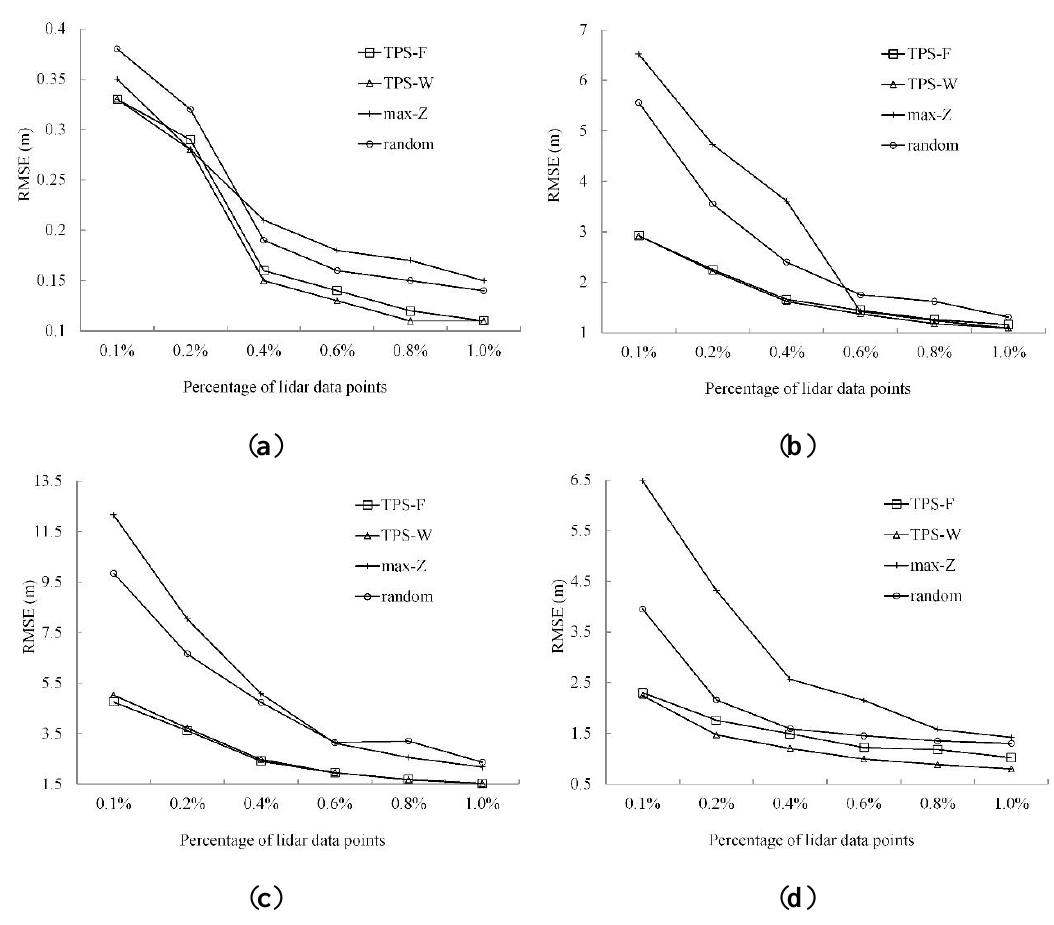
Figure 12. Comparison of percentage of LiDAR data points ( i.e. , ratio of the number of selected critical points to the whole number of LiDAR points) versus RMSE between the four methods in the sites with ( a ) flat, ( b ) undulating, ( c ) hilly and ( d ) mountainous